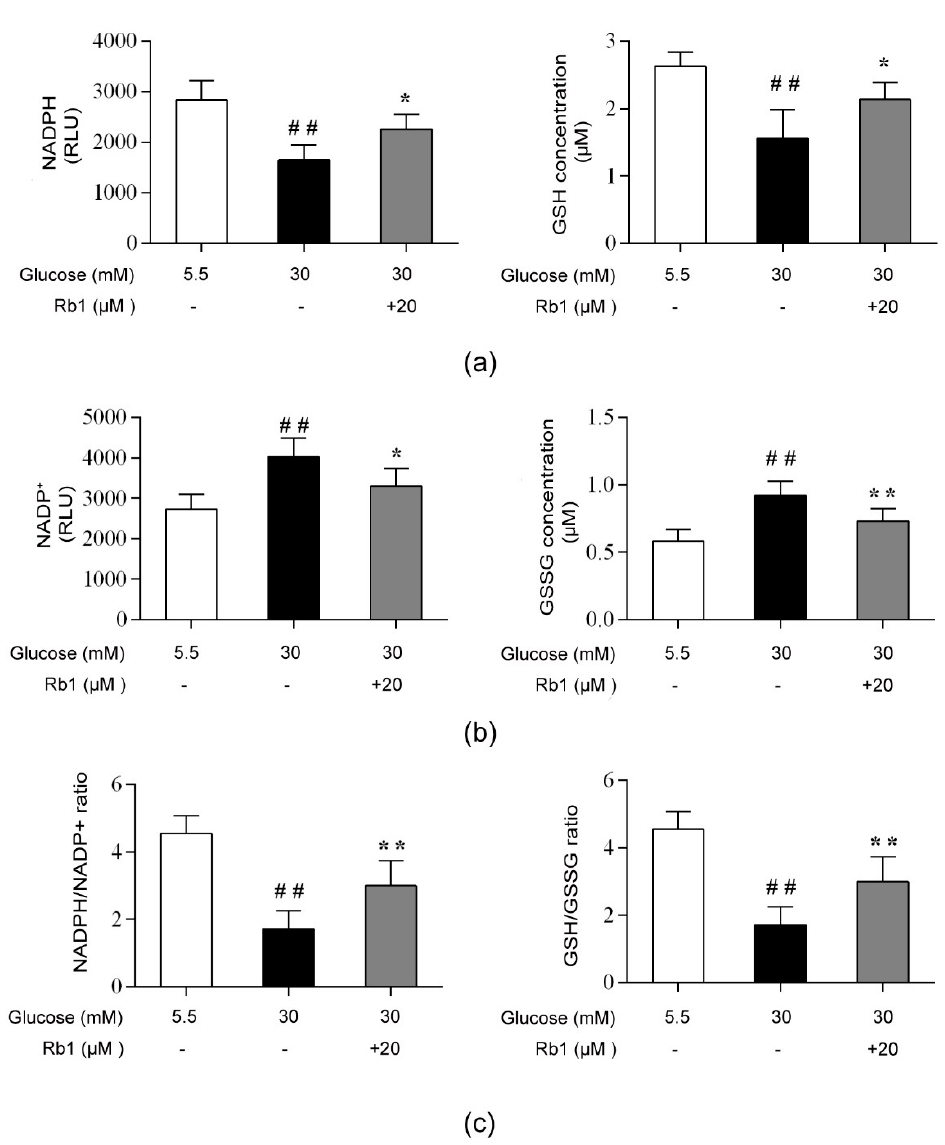
Figure 8. Rb1 modulated the NADPH / NADP + and glutathione (GSH) / GSSG ratios in RCECs exposed to high glucose. ( a ) NADPH and GSH levels. ( b ) NADP + and GSSG levels. ( c ) NADPH / NADP + and GSH / GSSG ratios. Data are expressed as the means ± SD. ## p < 0.01 versus 5.5 mM glucose; * p < 0.05 and ** p < 0.01 versus 30 mM glucose.